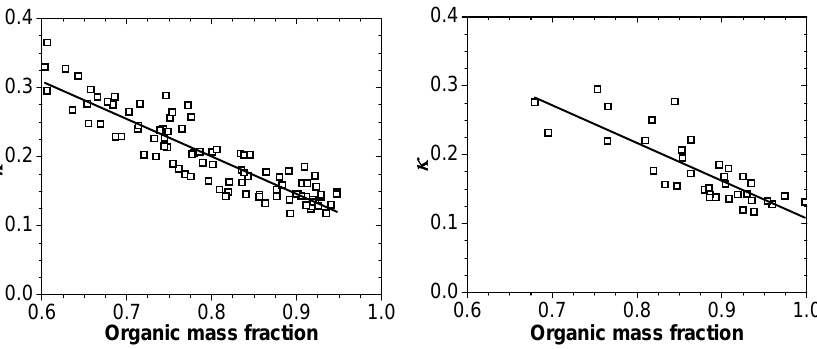
Fig. 13. Correlation between the effective hygroscopicity parameter of CCN-active particles ( κ a ) observed at S =0.1% and the organic mass fraction ( f org ) determined by (a) integral and (b) size-resolved AMS measurements. Linear fit equations, correlation coefficients, and numbers of data points: (a) y =0.634-0.543 x , R 2 =0.81, n =97; (b) y =0.656- 0.548 x , R 2 =0.66, n =36.